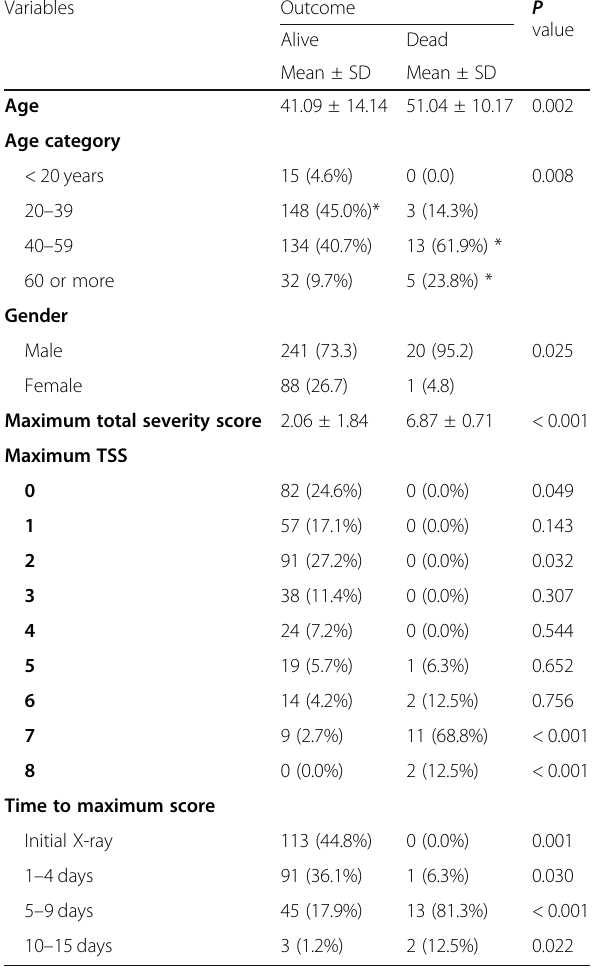
age, sex and maximum severity score